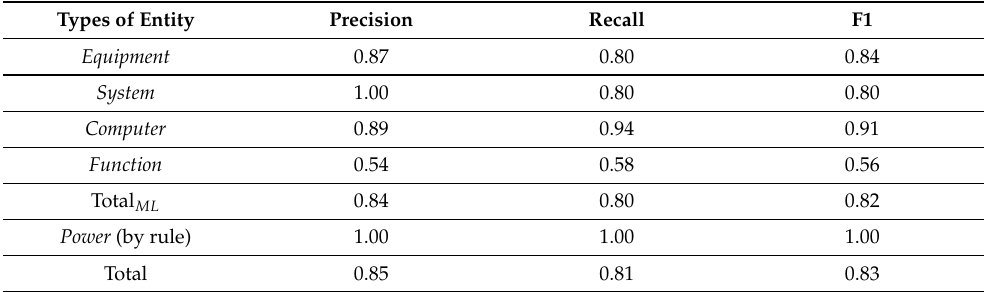
Table 5. The final results of NER: total _ embedding i = [ WORD i ; POS i ; PHRASE i ; HF i ]